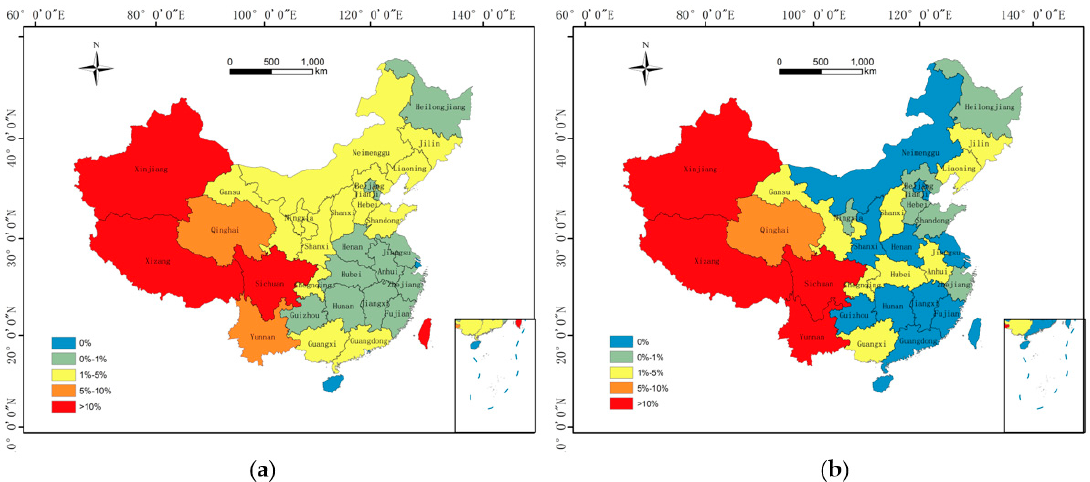
Figure 3. ( a ) Distribution of earthquake events at the province level from news reports from 2015 to 2017, ( b ) distribution of earthquake events at province level from professional reports from 2015 to 2017.